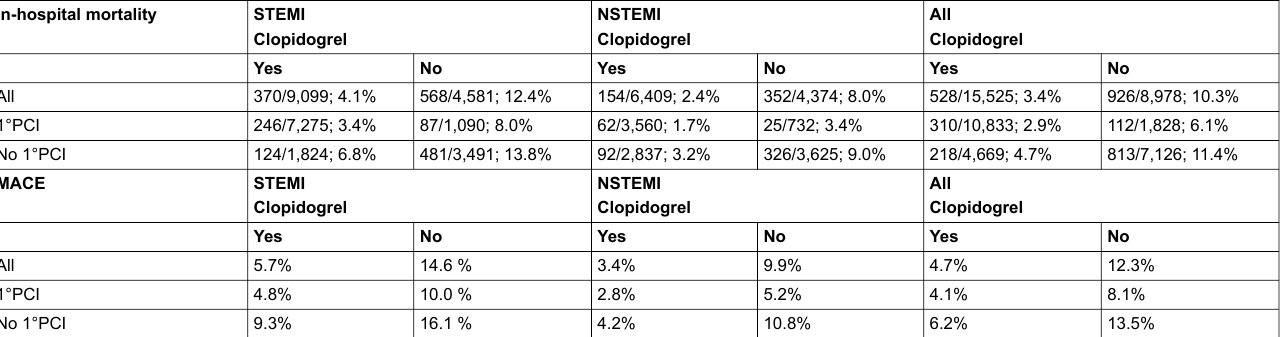
Table 3: In-hospital mortality and MACE. All proportions are statistically significantly different with respect to early clopidogrel administration ( p <0.0001, Fisher's exact test). In-hospital